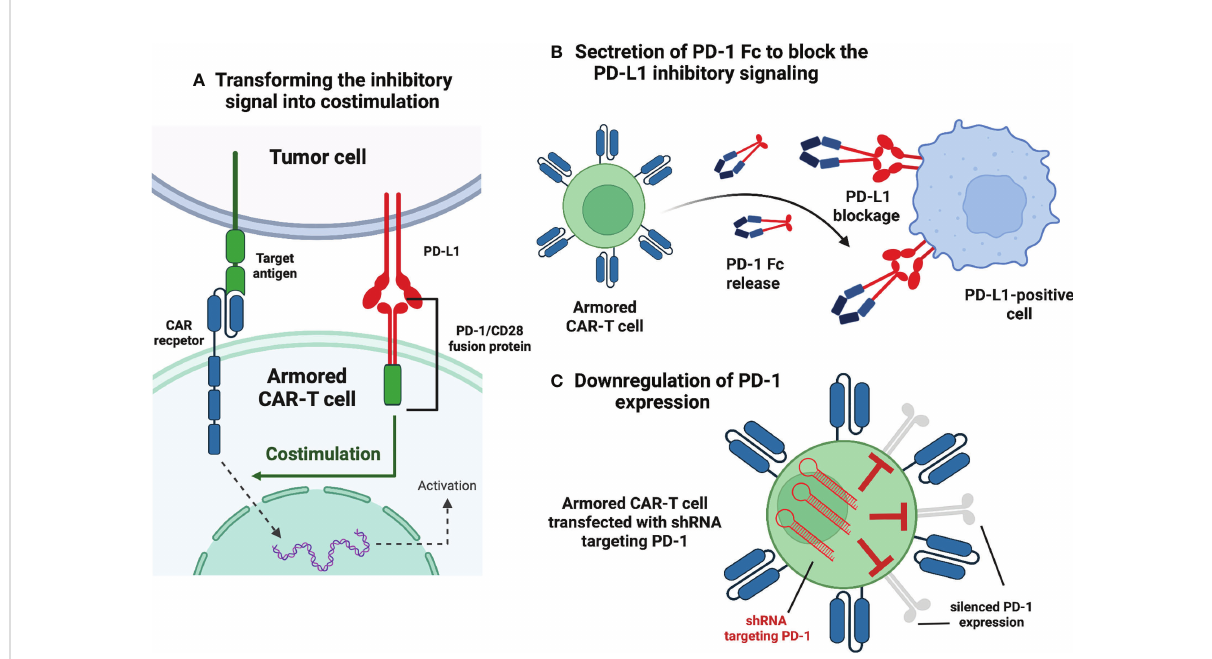
FIGURE 2 Armored CAR-T cells – immune checkpoint modulation. (A) Transforming the inhibitory signal into stimulation. This construct embodies the extracellular PD-1 domain fused to the intracellular CD28. Interaction between PD-1 and PD-L1 (expressed in the tumor microenvironment) is transformed into activating signal and leads to the enhanced CAR-T response. (B) Secretion of PD-1 Fc to block PD-L1 inhibitory signaling. The CAR-T cell is programmed to express and secrete a protein that combines the PD-1 domain and fragment crystallizable region (Fc) of an antibody. The secreted protein blocks PD-L1 molecules of malignant cells and makes them susceptible to innate immune cells. (C) Downregulation of PD-1 expression. The CAR-T cells are transfected with short hairpin RNA (shRNA) and subsequently, PD-1 expression is silenced via RNA interference. Created with